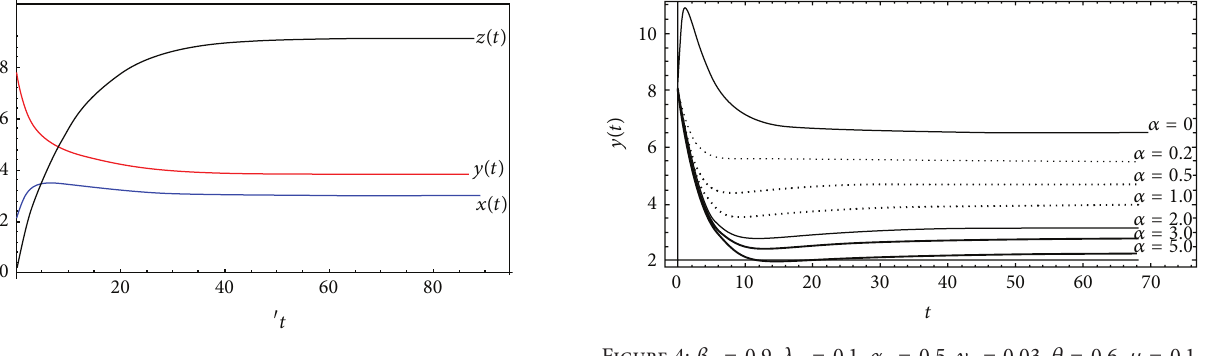
Figure 3: 𝑅 0 > 1 ; the rumor persists at an “endemic” level. the balance, respectively. Finally, the number of spreaders is zero and this leads to the termination of rumor spreading.